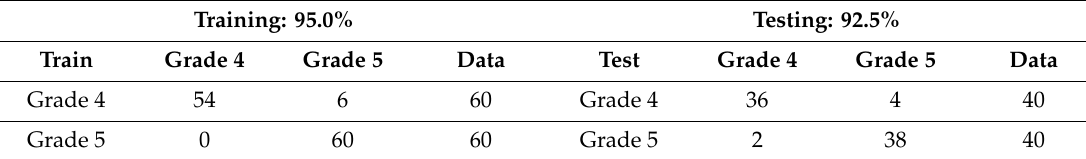
Table 4. Confusion matrix of SVM binary classification—Grade 4 vs. Grade